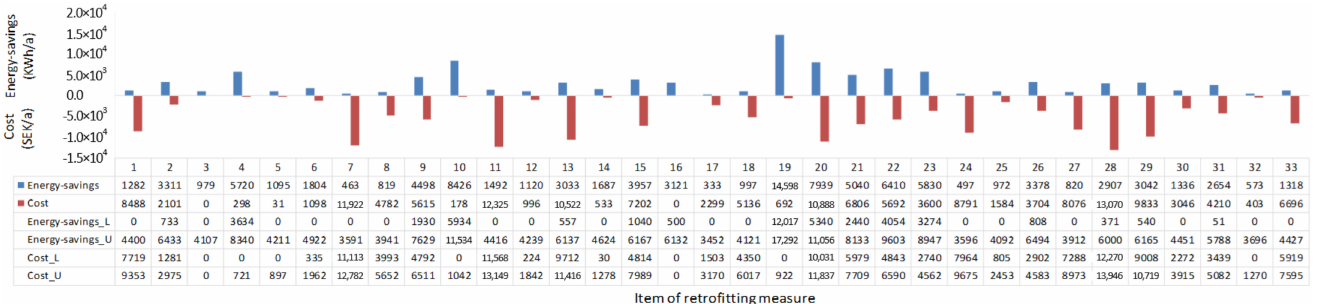
Figure 7. The energy-saving and cost of Building #5 with average and PI under different retrofitting